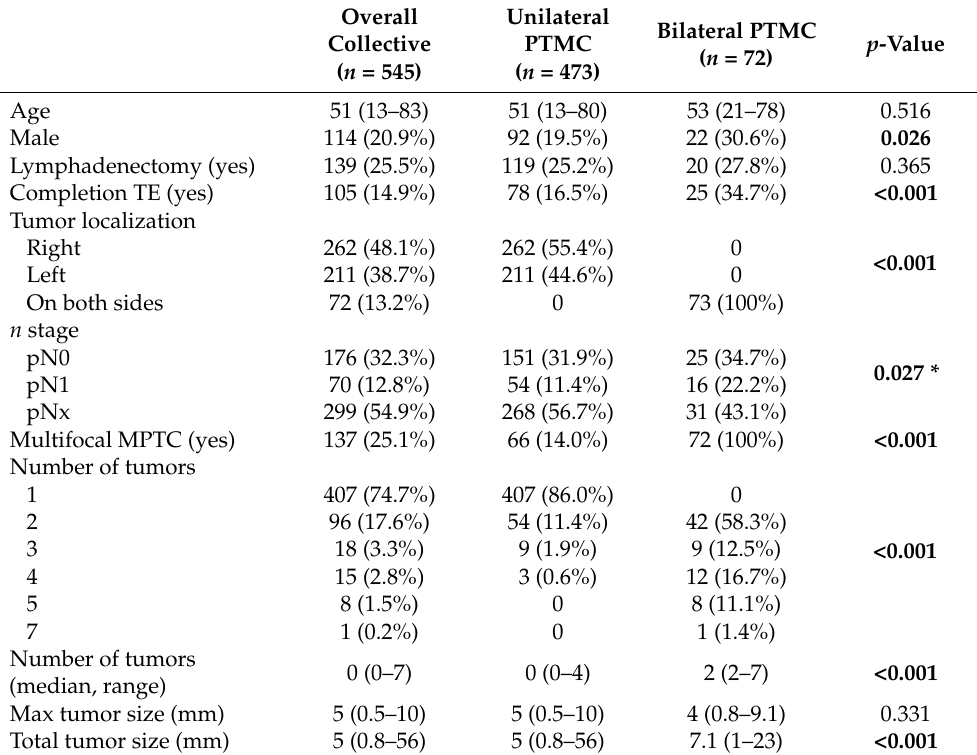
Table 1. Patient